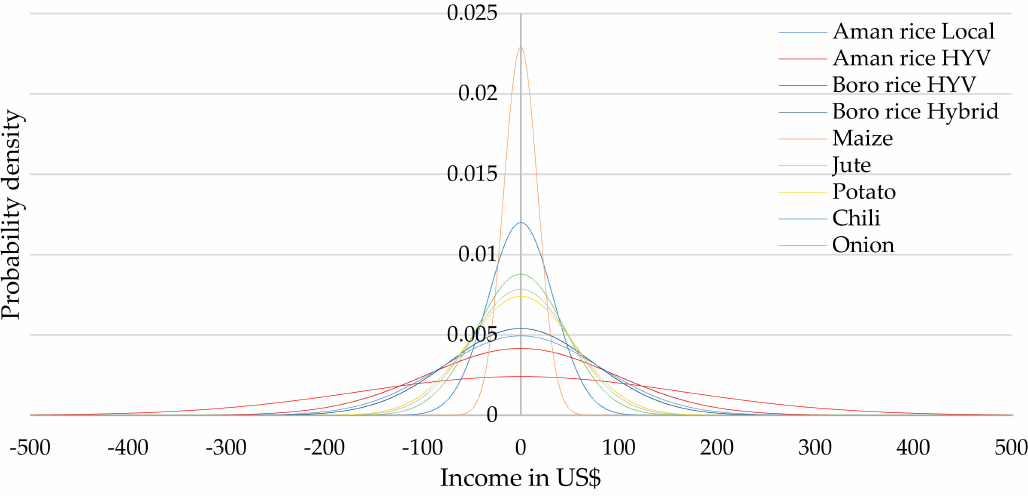
Figure 7. Distribution of agricultural income for farm households in Bangladesh by crop income.